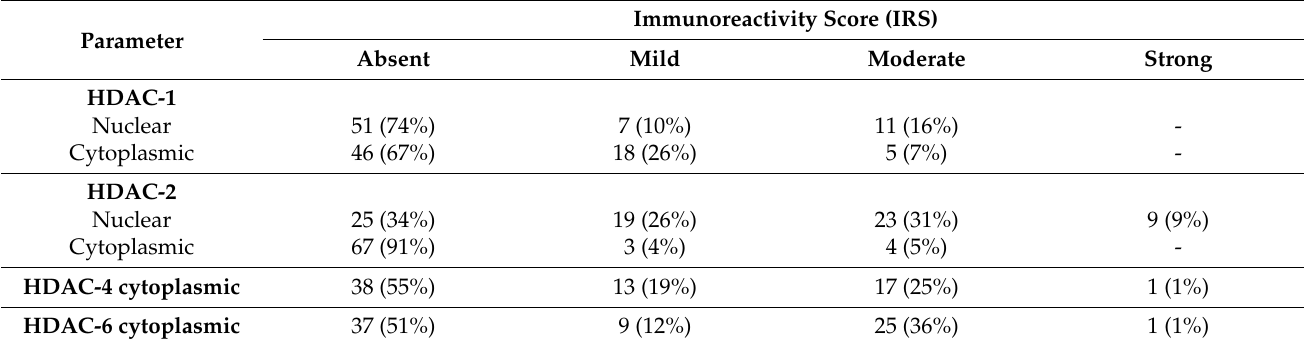
Table 2. Immunohistochemical expression of HDAC-1, -2, -4, and -6 in UMs.